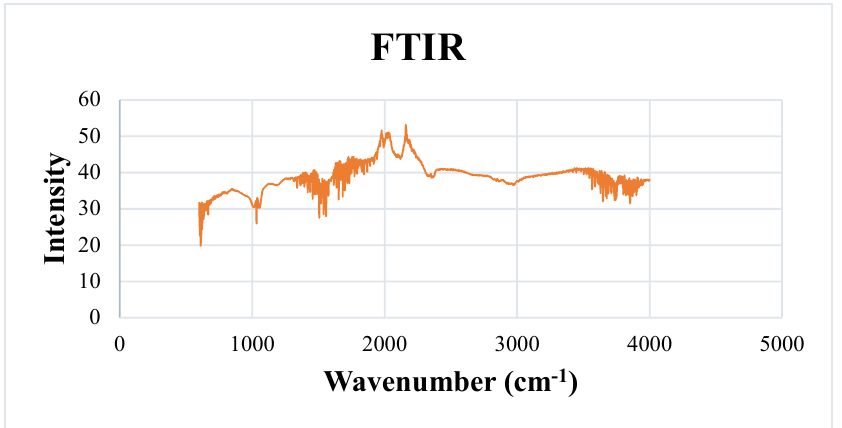
Figure 5 . FTIR analysis of ZVI - NPs showing capping and reducing functional groups of seed extract Figure 5. FTIR analysis of ZVI-NPs showing capping and reducing functional groups of seed extract Nigella sativa thus stabilizing the synthesized NPs . Nigella sativa thus stabilizing the synthesized NPs.